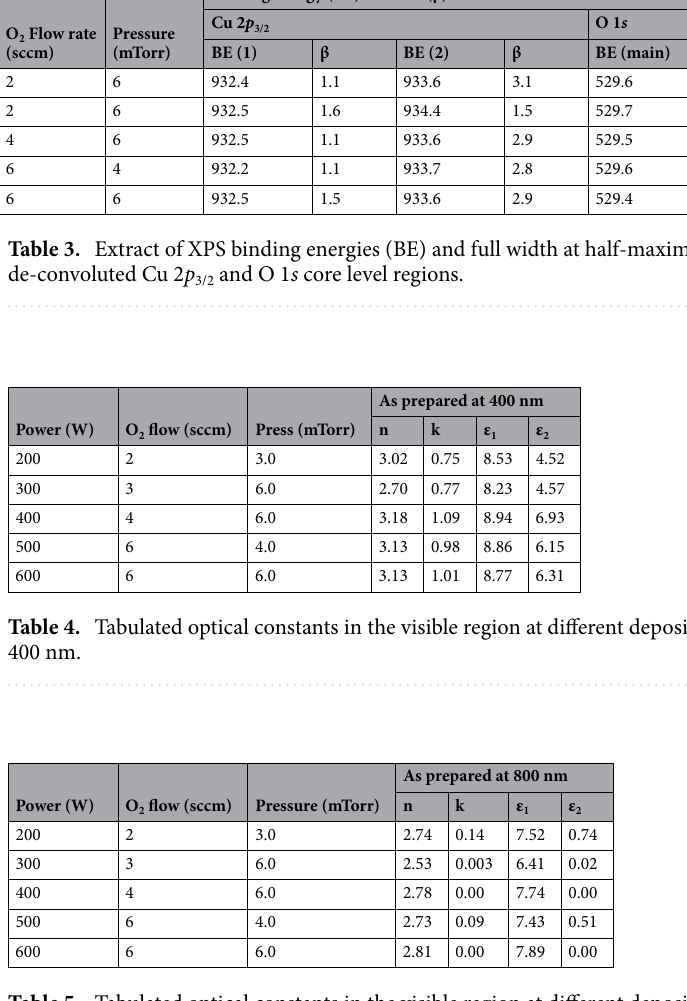
Table 5. Tabulated optical constants in the visible region at different deposition conditions as prepared at 800 nm.